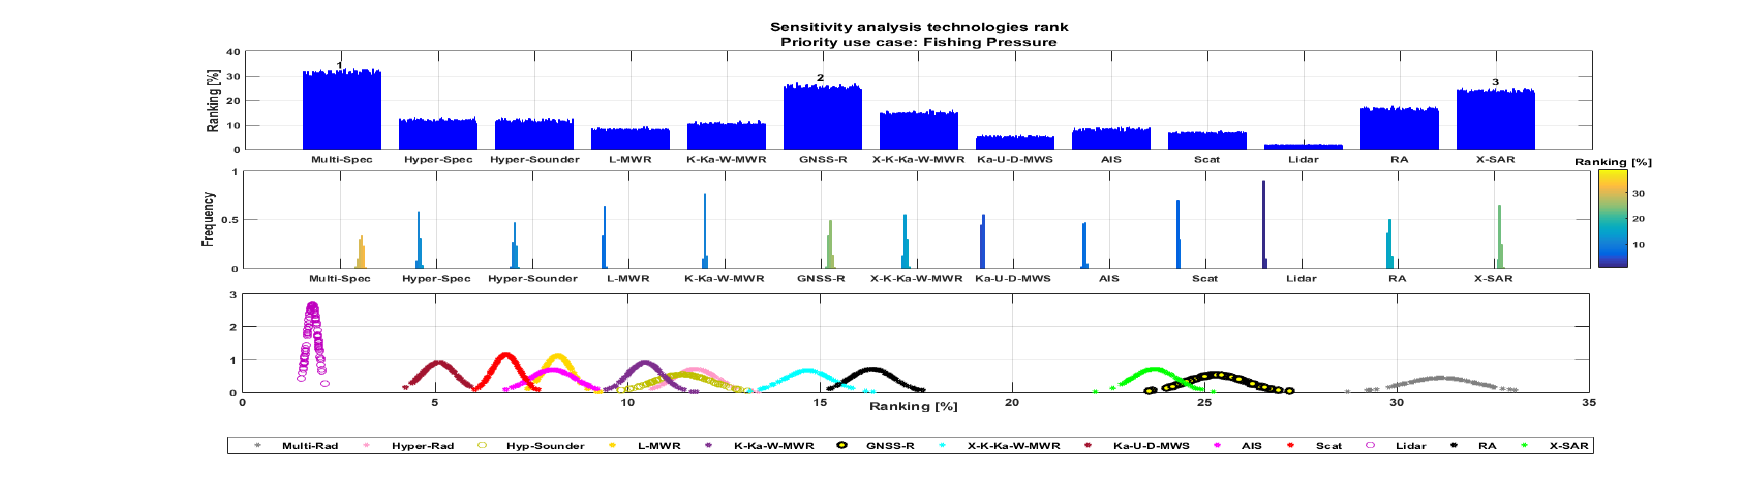
Figure 3. Sensitivity analysis at 25% for different use cases priorities. ( a ) Marine for Weather Forecast; ( b ) Sea Ice Monitoring; ( c ) Fishing Pressure; ( d ) Agriculture and Forestry: Hydric